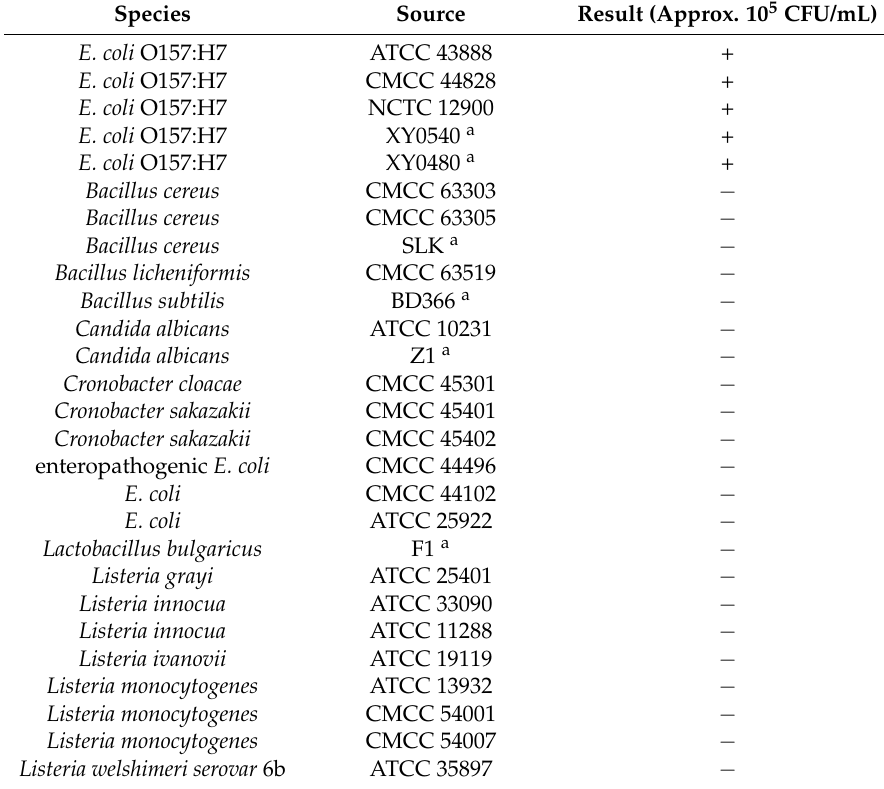
Table 1. Specificity of the Au-LFIA strip to E. coli